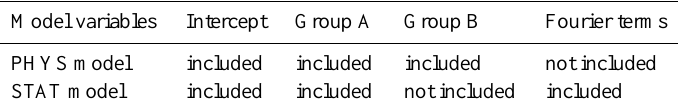
included included included not included included included not included